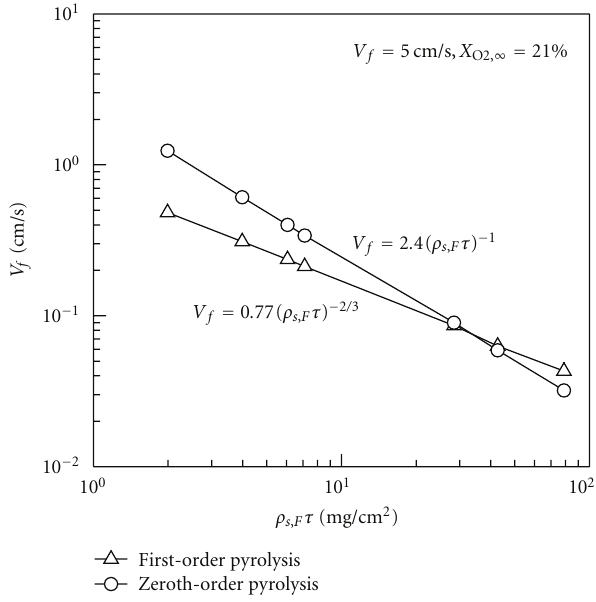
Figure 9: Thickness e ff ect on spread rate for both pyrolysis